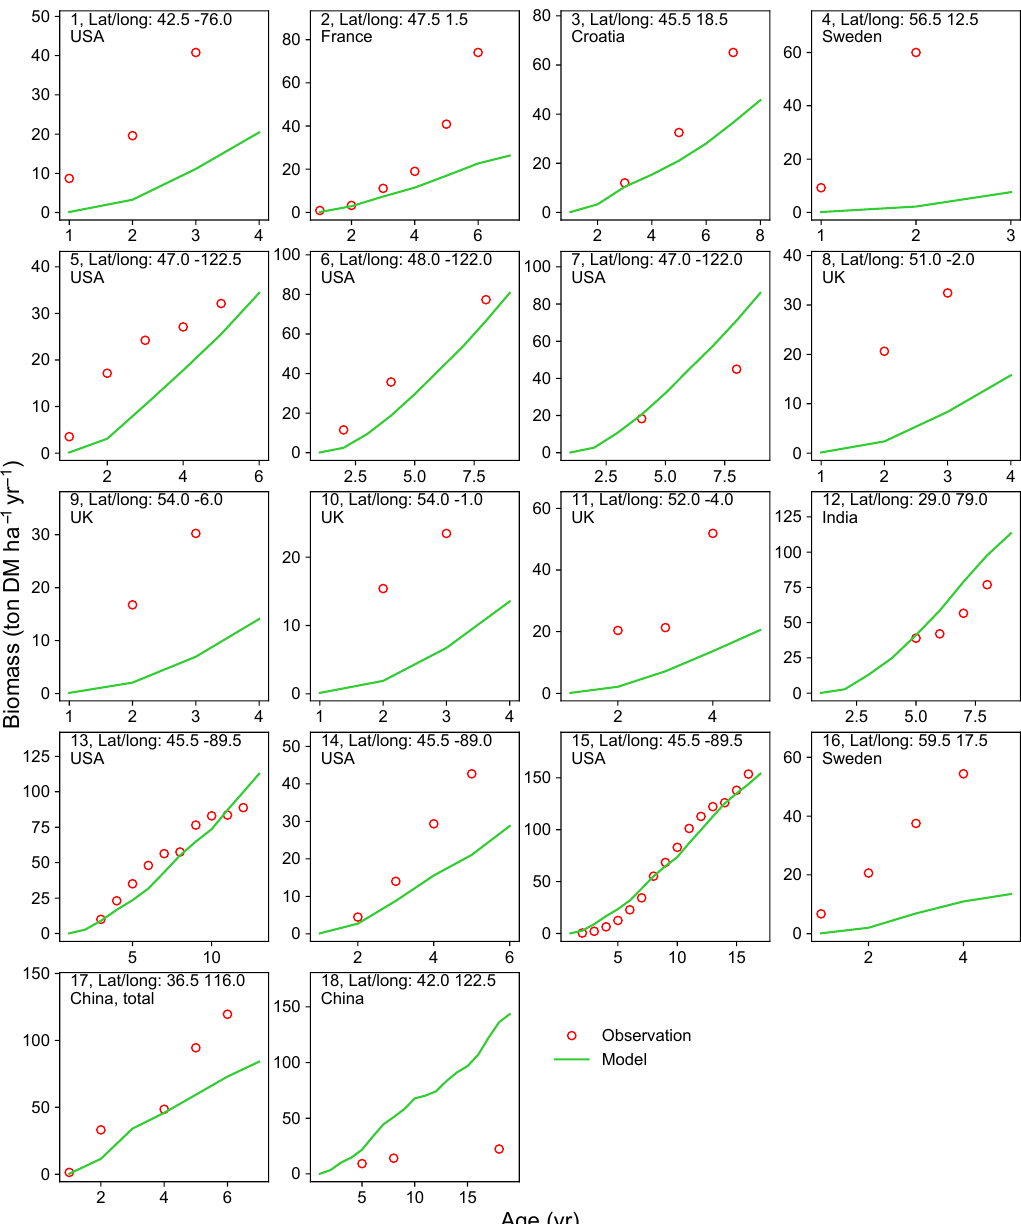
Figure 5. Biomass–age curves at different sites for PFT15 (temperate bioenergy tree, poplar and willow). The site number, coordinates, and country for each site are also shown. Biomass at most sites refers to aboveground biomass, except Site no. 17 (labeled “total”, i.e., the sum of aboveground and belowground biomass; the same total biomass from the model is used for this site.). The detailed site information is shown in Table